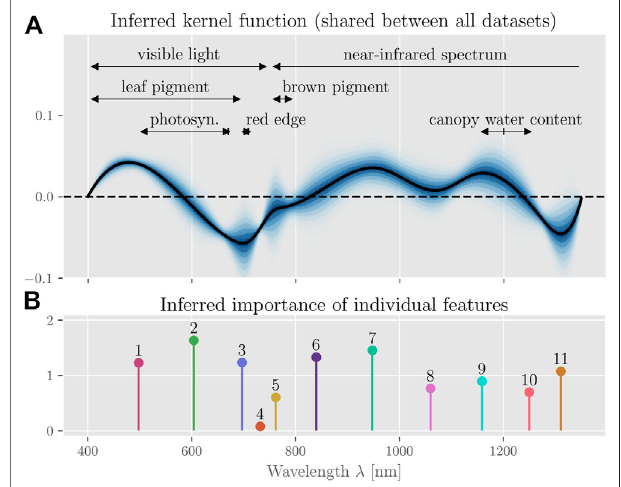
FIGURE 6 | Inferred kernel function and feature importance. (A) shows the posterior distribution of the inferred kernel function. The black line represents the expected kernel. We can relate several ranges of the re fl ectance spectrum to physical phenomena, namely effects due to green leaf pigment [400 – 700 nm (Cen and Borman, 1990; Aparicio et al., 2000)] and photosynthetic capacity [495 – 680 nm, peak at 670 nm (Cen and Borman, 1990; Aparicio et al., 2000; Weber et al., 2012)] and the red edge region [690 – 720 nm (Zhang et al., 2016)] in the visible light range, as well as the canopy ’ s water content [1,150 nm – 1,260 nm (Sims and Gamon, 2003), peak absorption at around 1,200 nm (Weber et al., 2012; Wang C et al., 2017)] in the near-infrared range. (B) shows a stem-plot of the relative importance of each feature (enumerated; normalized by the average